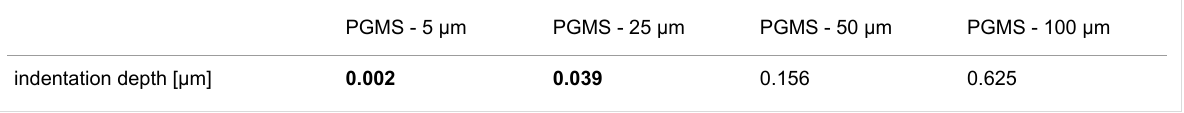
Table 4: Calculated indentation of the glass ball into the PGMS depending on their pitch dimension. The calculated values, which lay beyond the spacial resolution of the system in normal direction (50 nm), are highlighted in bold.